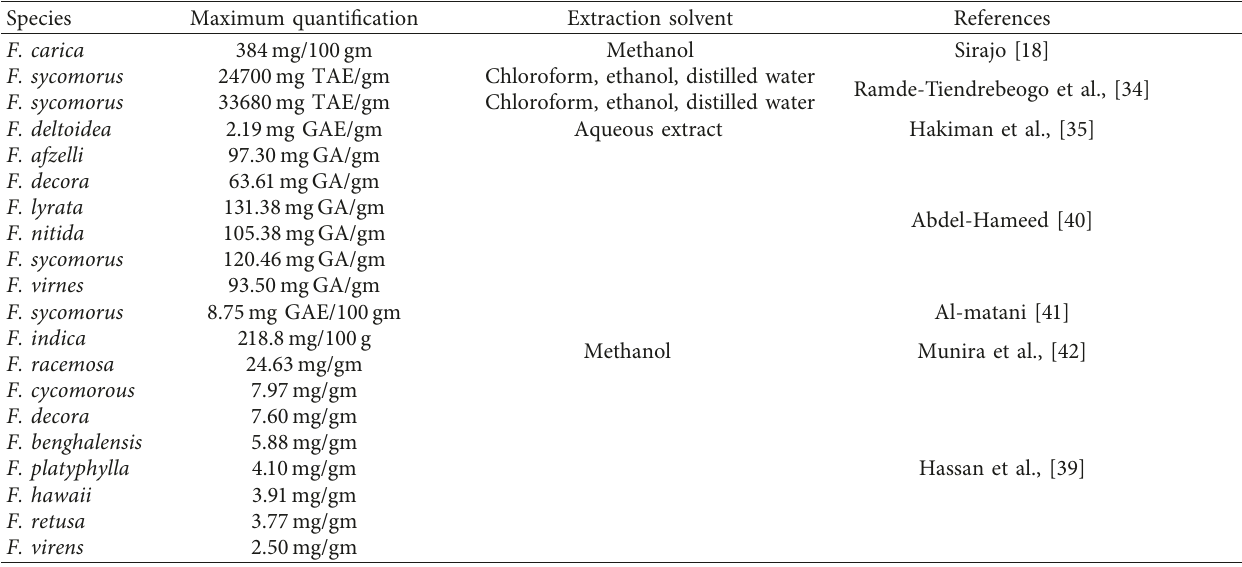
Table 4: Total phenols present in the species used as both fresh fruit and species belonging to genus Ficus .